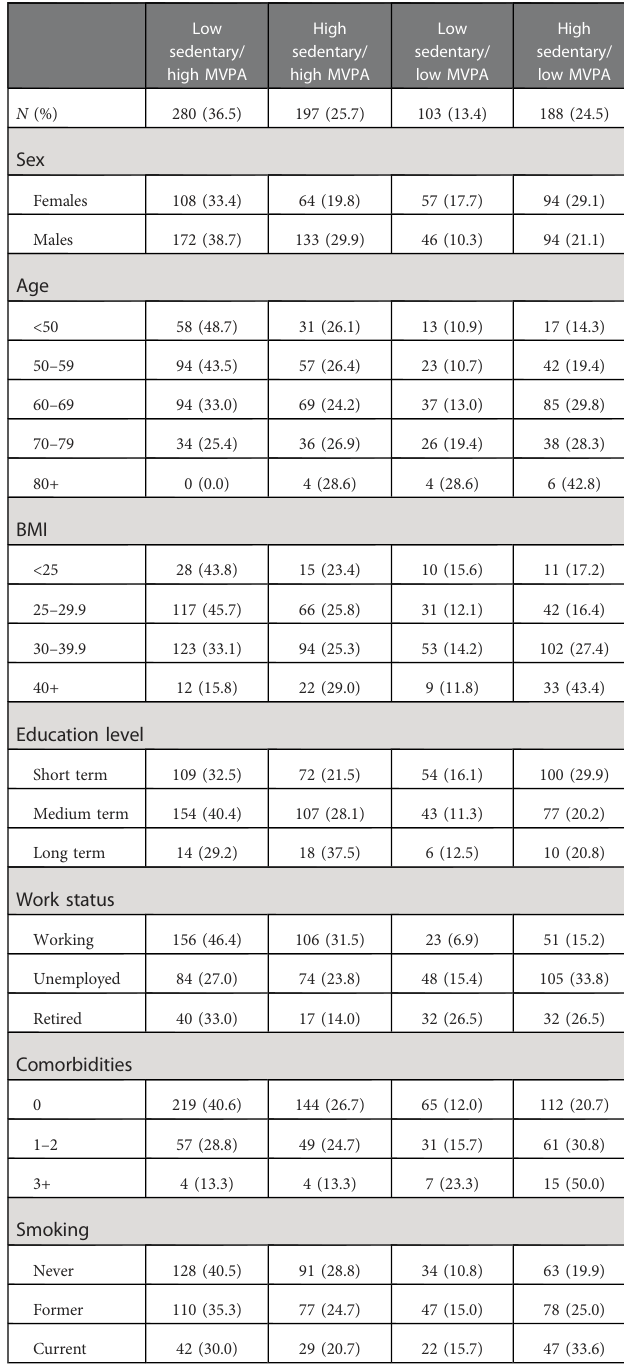
TABLE 3 Proportions of study participants within each strata of sociodemographic and health-related factors strati fi ed by physical activity pro fi